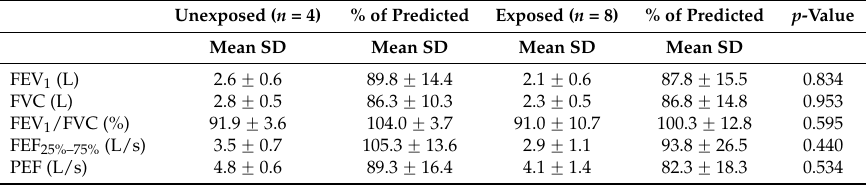
Table 3. Lung function data in self-reported unexposed versus exposed children. Unexposed ( n = 4) % of Predicted Exposed ( n = 8) % of Predicted p